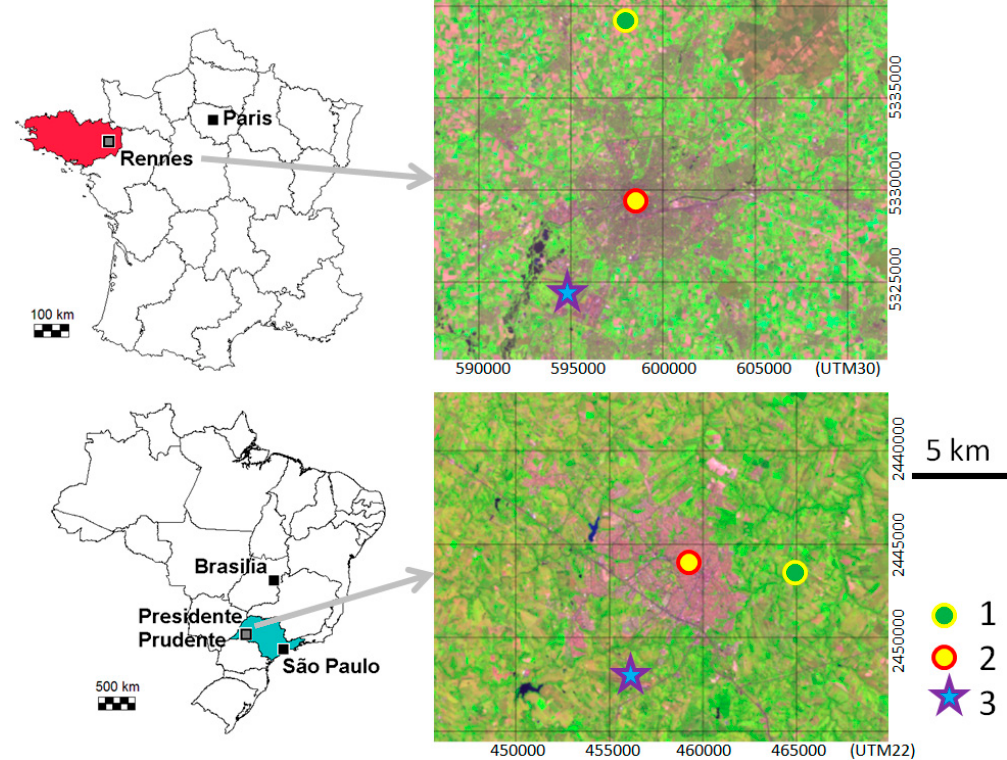
Figure 1. Location: Rennes ( above ) and Presidente Prudente ( below ). The right, colored composition of the image taken in 2014 by Landsat-8 for each city, at the same scale. Legend: 1 = rural area measurement point; 2 = city center measuring point; 3 = synoptic reference station (historical data).